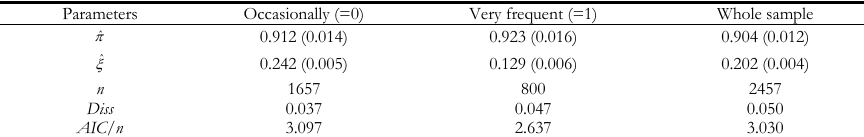
CUB models of Global satisfaction for Orientation